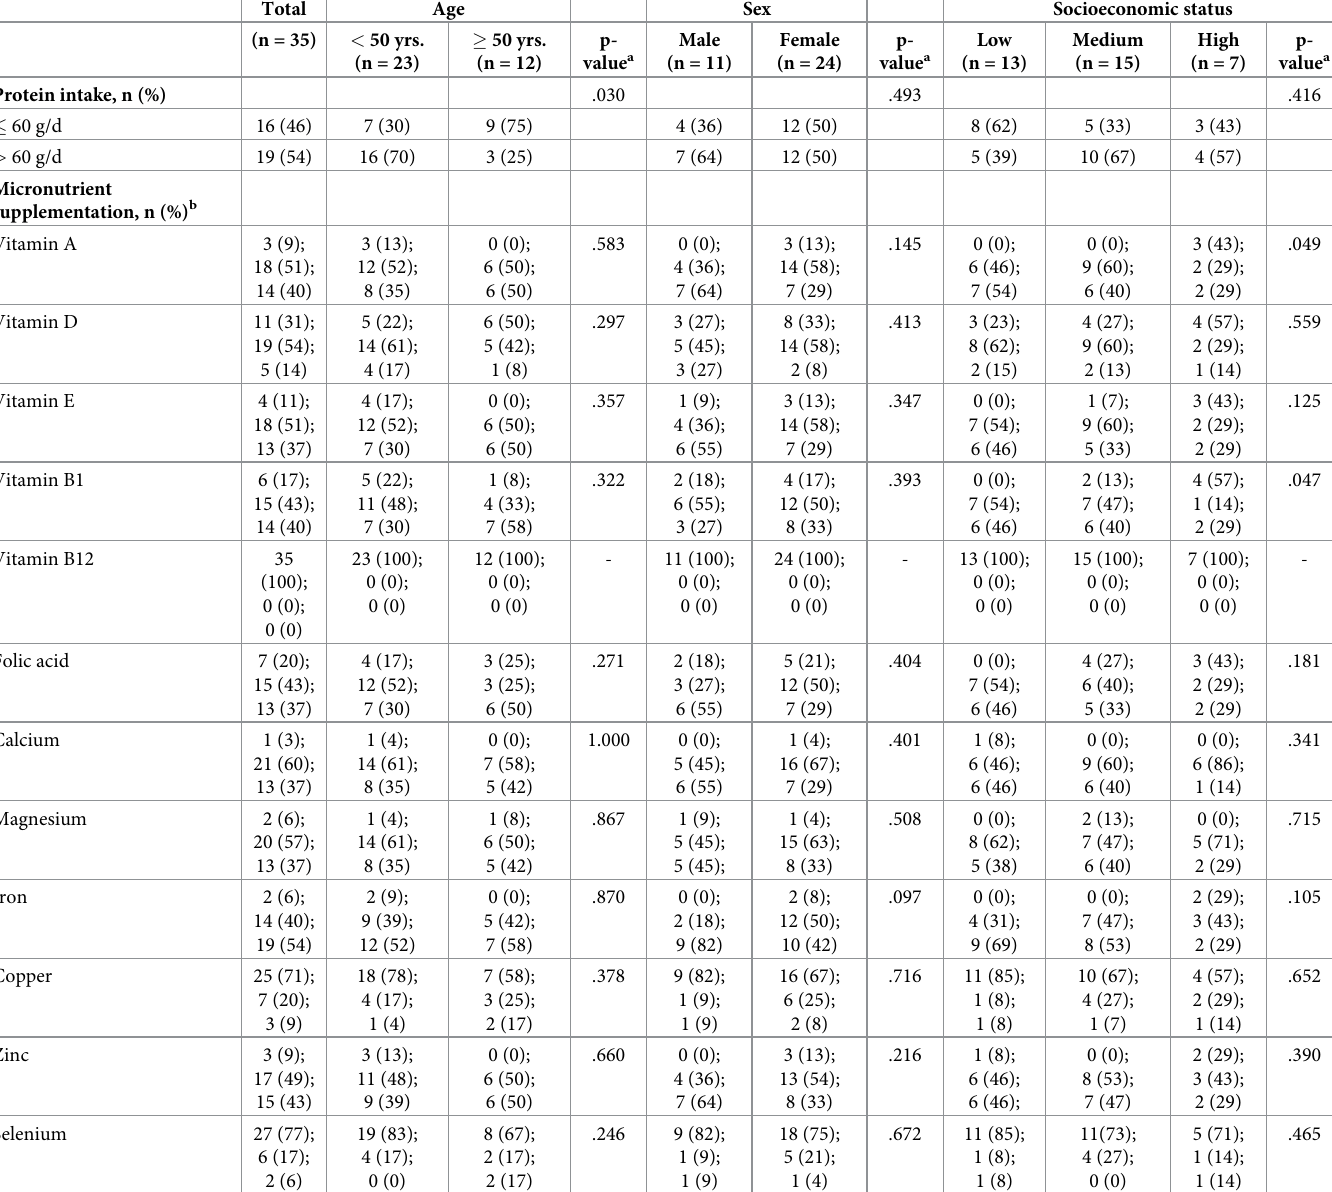
Table 2. Adherence to the German S3 guideline recommendations on protein intake and micronutrient supplementation in patients after bariatric surgery overall and by